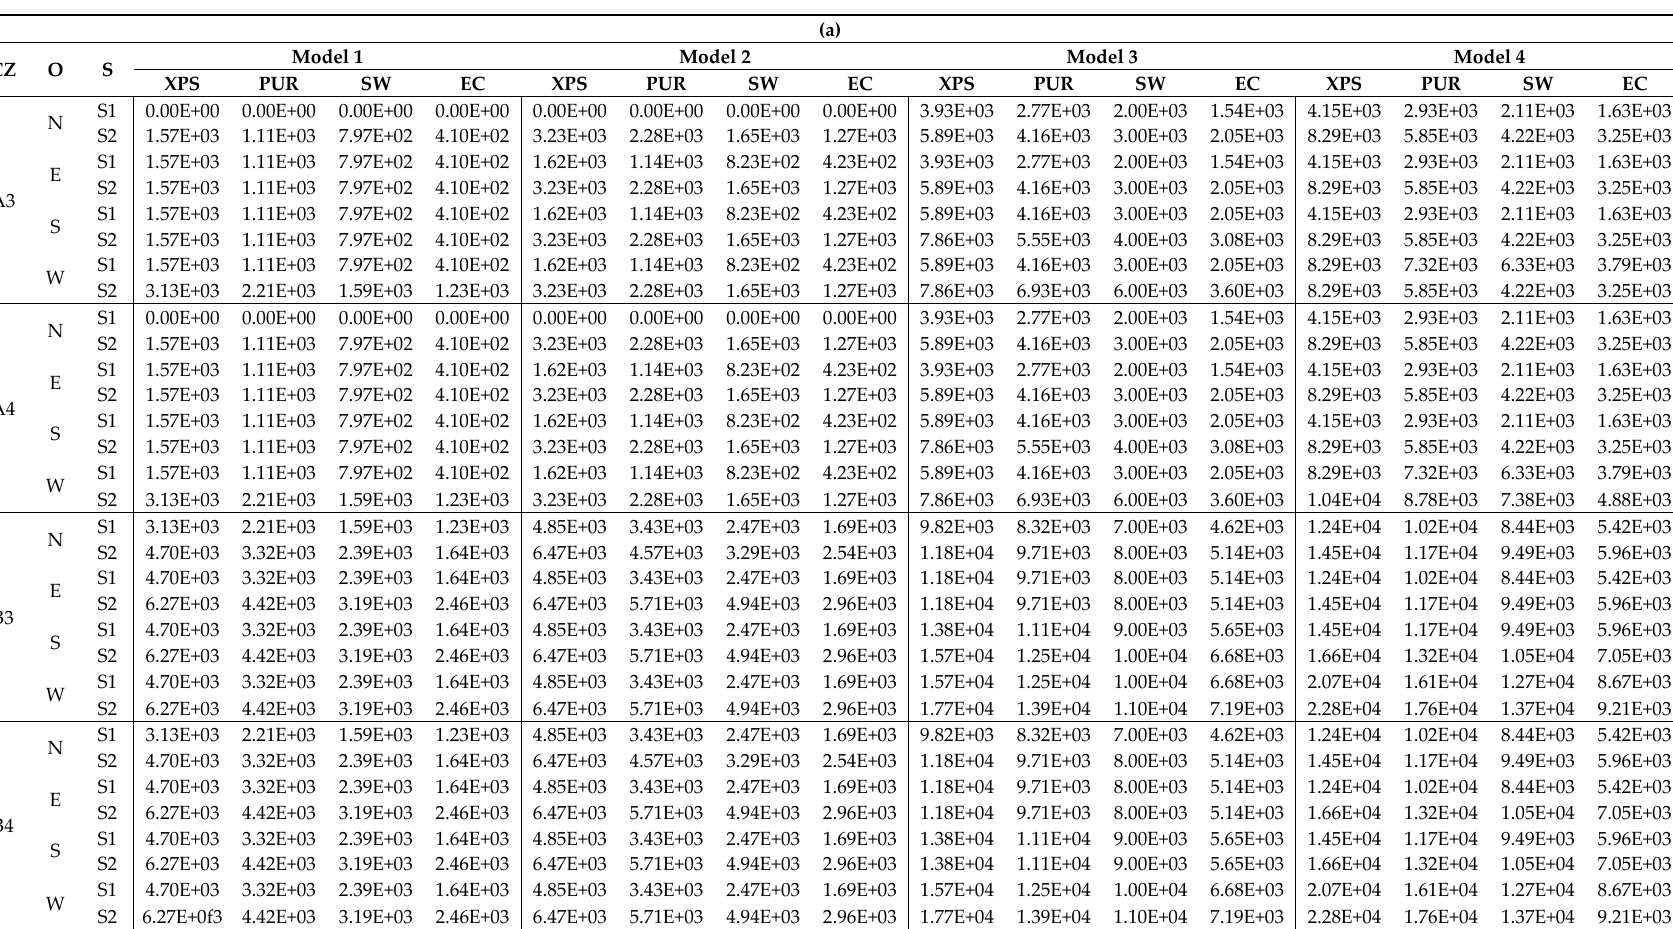
Table A4. Emissions of CO 2 according to climate zone (CZ), orientation (O), constructive solution (S), building model and insulation material model (in Kg CO 2 ), for H1.